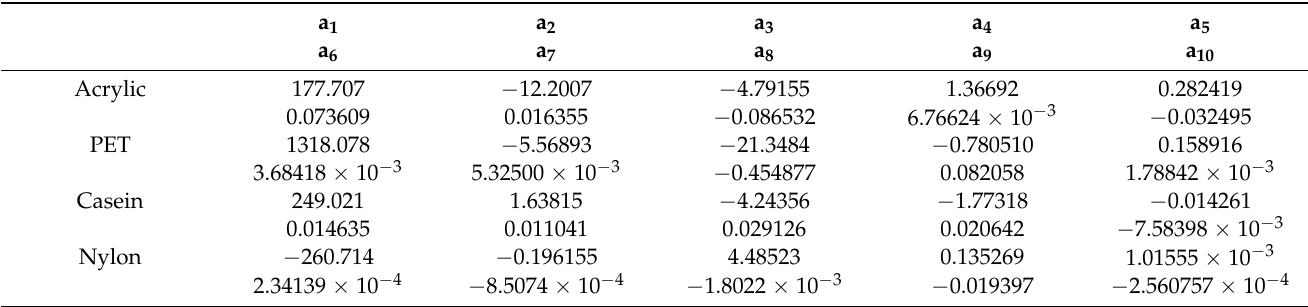
Table 4. Regression parameters of Equation